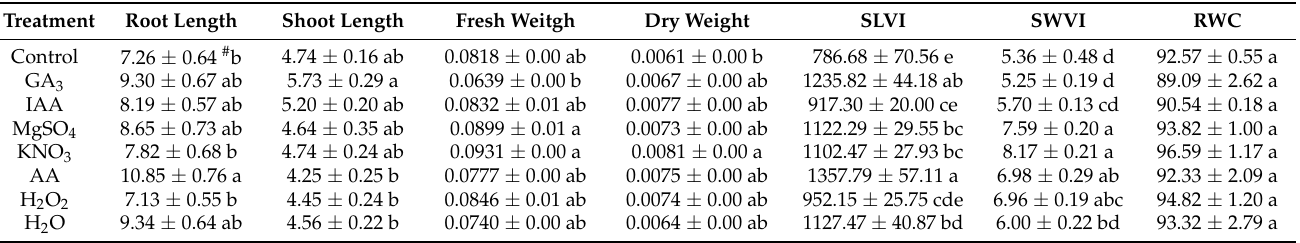
Table 2. Effect of different priming treatments on shoot and root length (cm), fresh and dry weight (g), leaf relative water content—RWC (%), seedling weight vigor index (SWVI), and seedling length vigor index (SWVI) of radish ( R. sativus ).